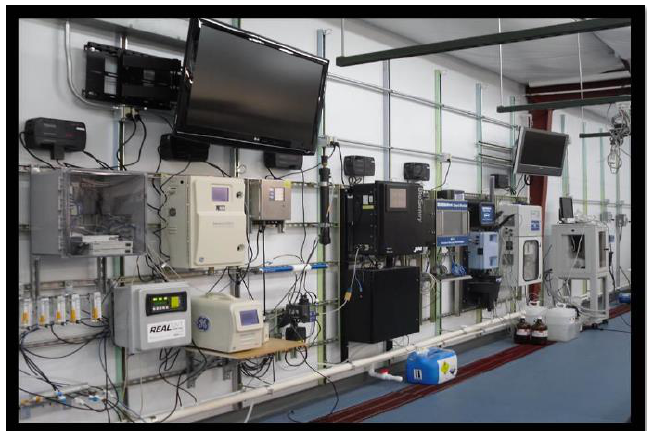
Figure 1. Real-time Sensor Laboratory.